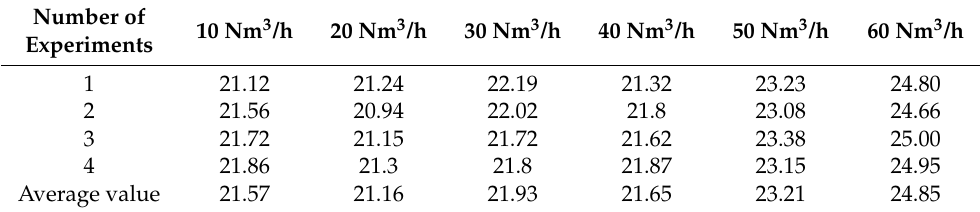
Table 15. Liquid particle size in Case 4 at M 1 ( µ m).